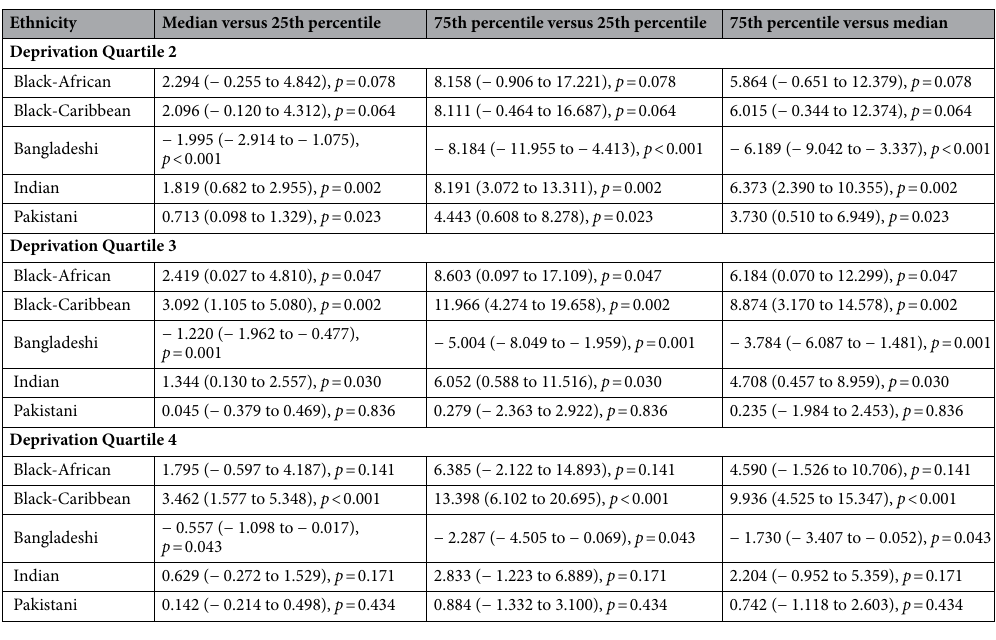
Table 3. Marginal effects of ethnicity on age adjusted mortality, spatial regression model: coefficients (95% confidence interval, P